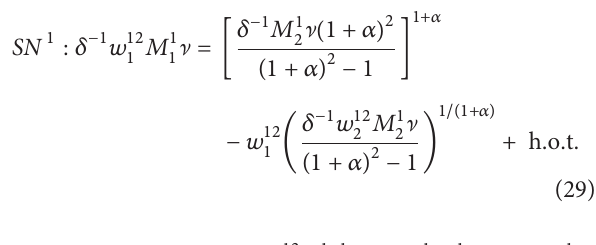
Figure 4: Bifurcation diagram in case Δ 1 = Δ 2 = −1 , 0 < 𝛼 ≪ 1 , −1 ≪ 𝛼 ln |𝑀 1